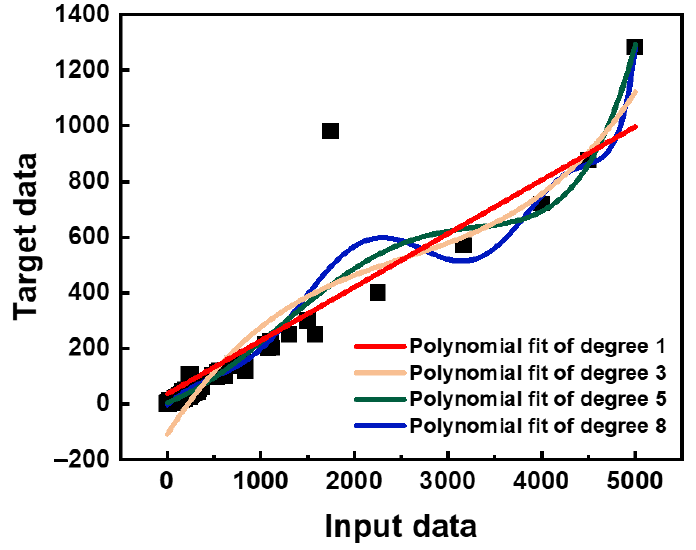
Figure 2. Effect of changing the degree of the polynomial regression on the learning curve. The black squares represent the data samples.